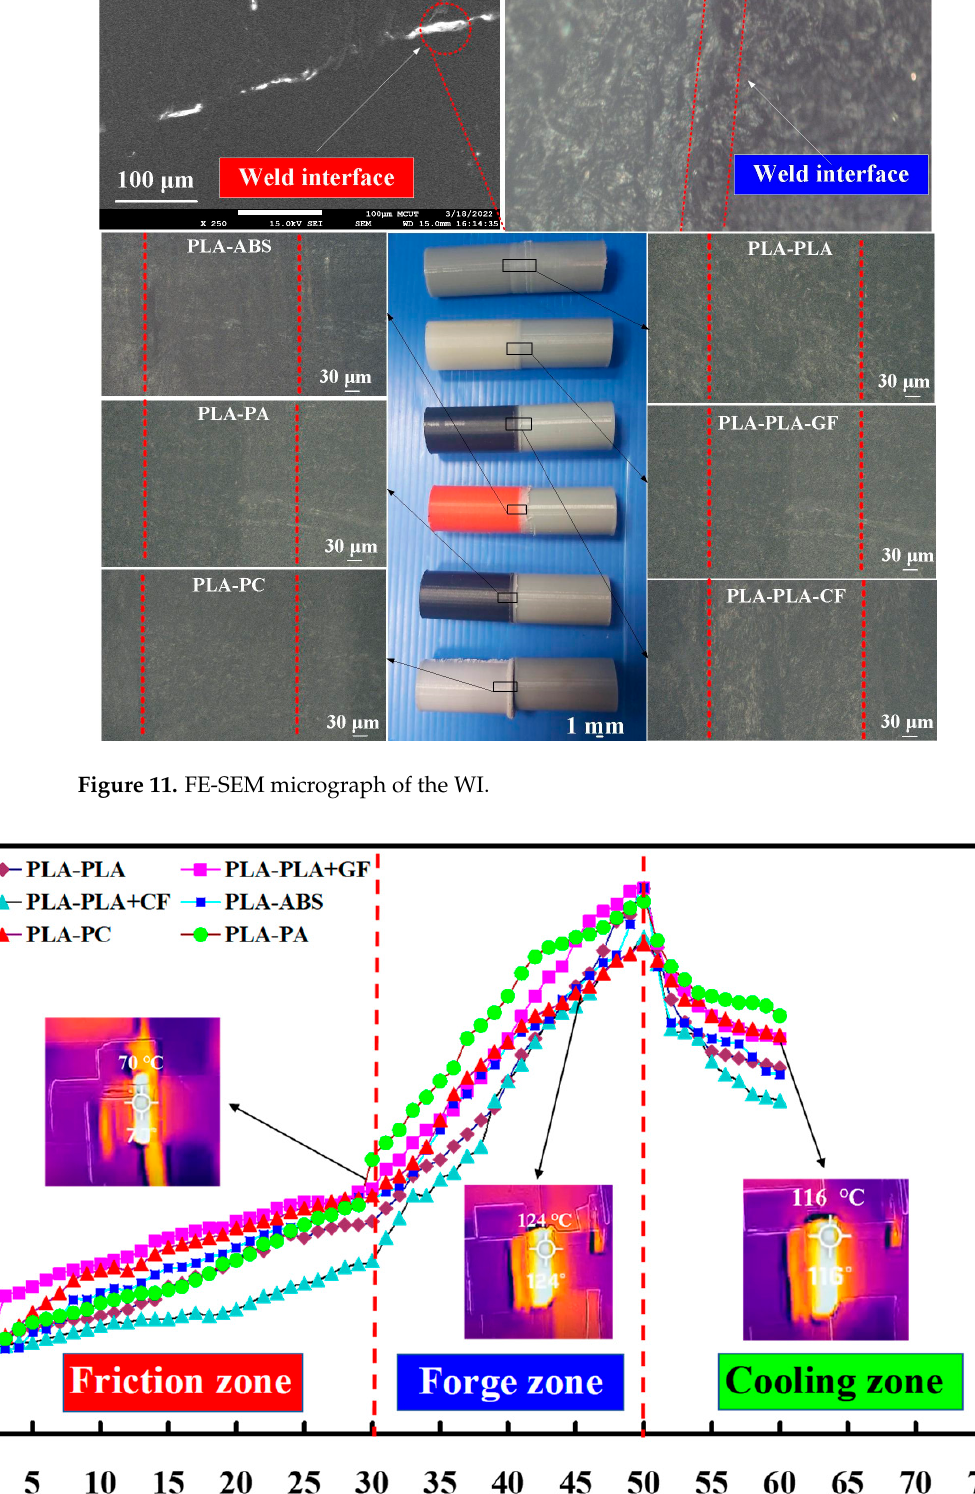
Figure 12. WI temperature as a function of welding time for six dissimilar joints.